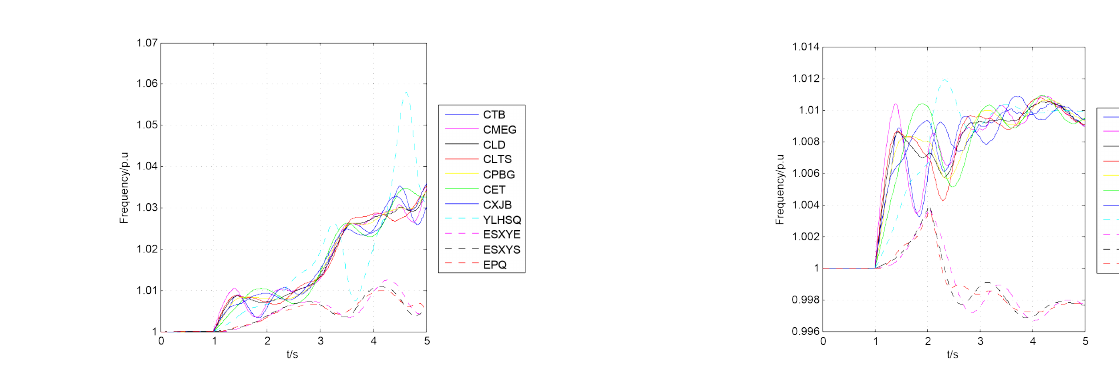
c: The generator frequency curves without islanding. f: The generator frequency curves with islanding. Figure 21. Comparisons with and without the islanding on the reduced power grid of Central China.